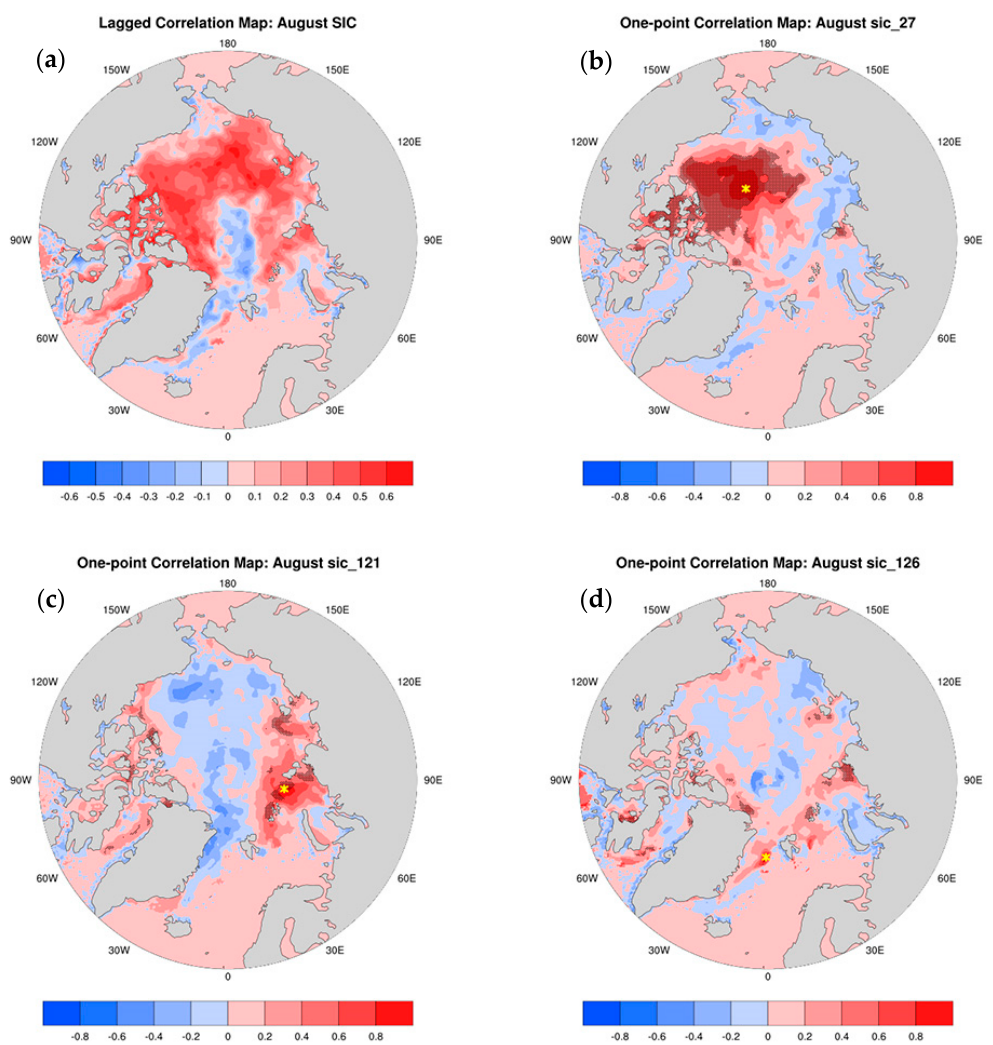
Figure 3. ( a ) Correlation map (shade interval: 0.1) of August SIC with the September Arctic SIE over 1980–2017; ( b – d ) one-point correlation maps (shade interval: 0.2) of three precursors (August sic_27 , sic_121 and sic_126 ) where the values represent the correlation coefficients of each precursor with the August SIC anomaly field north of 60 ◦ N, respectively. The geometric mid-point (base grid) of each precursor is marked as a yellow asterisk. Black dots denote the points significantly correlated with each base grid at the 95% ( p < 0.05) confidence level. Red (blue) shadings indicate the positive (negative) correlations.